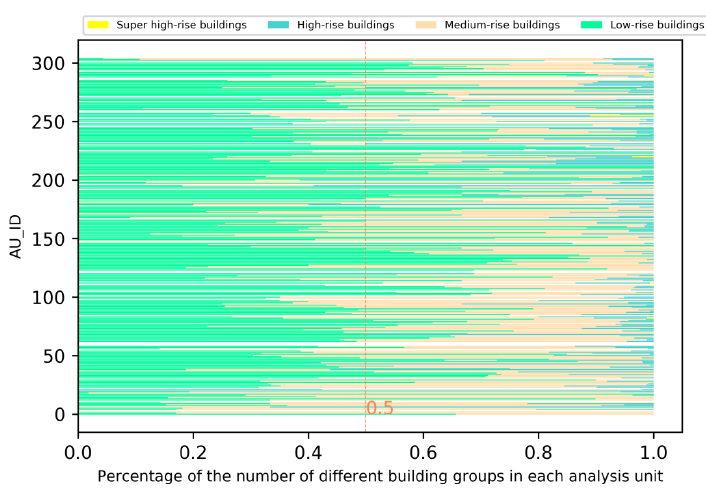
Figure 2. Percentage of the number of di ff erent building groups in each analysis unit. AU_ID: the unique number of each analysis